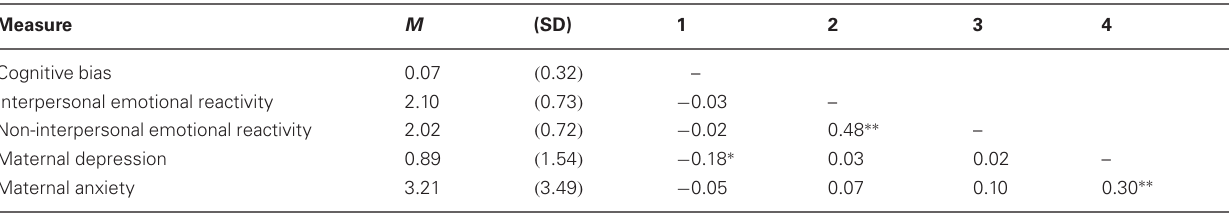
Table 1 | Descriptive information and intercorrelations among the